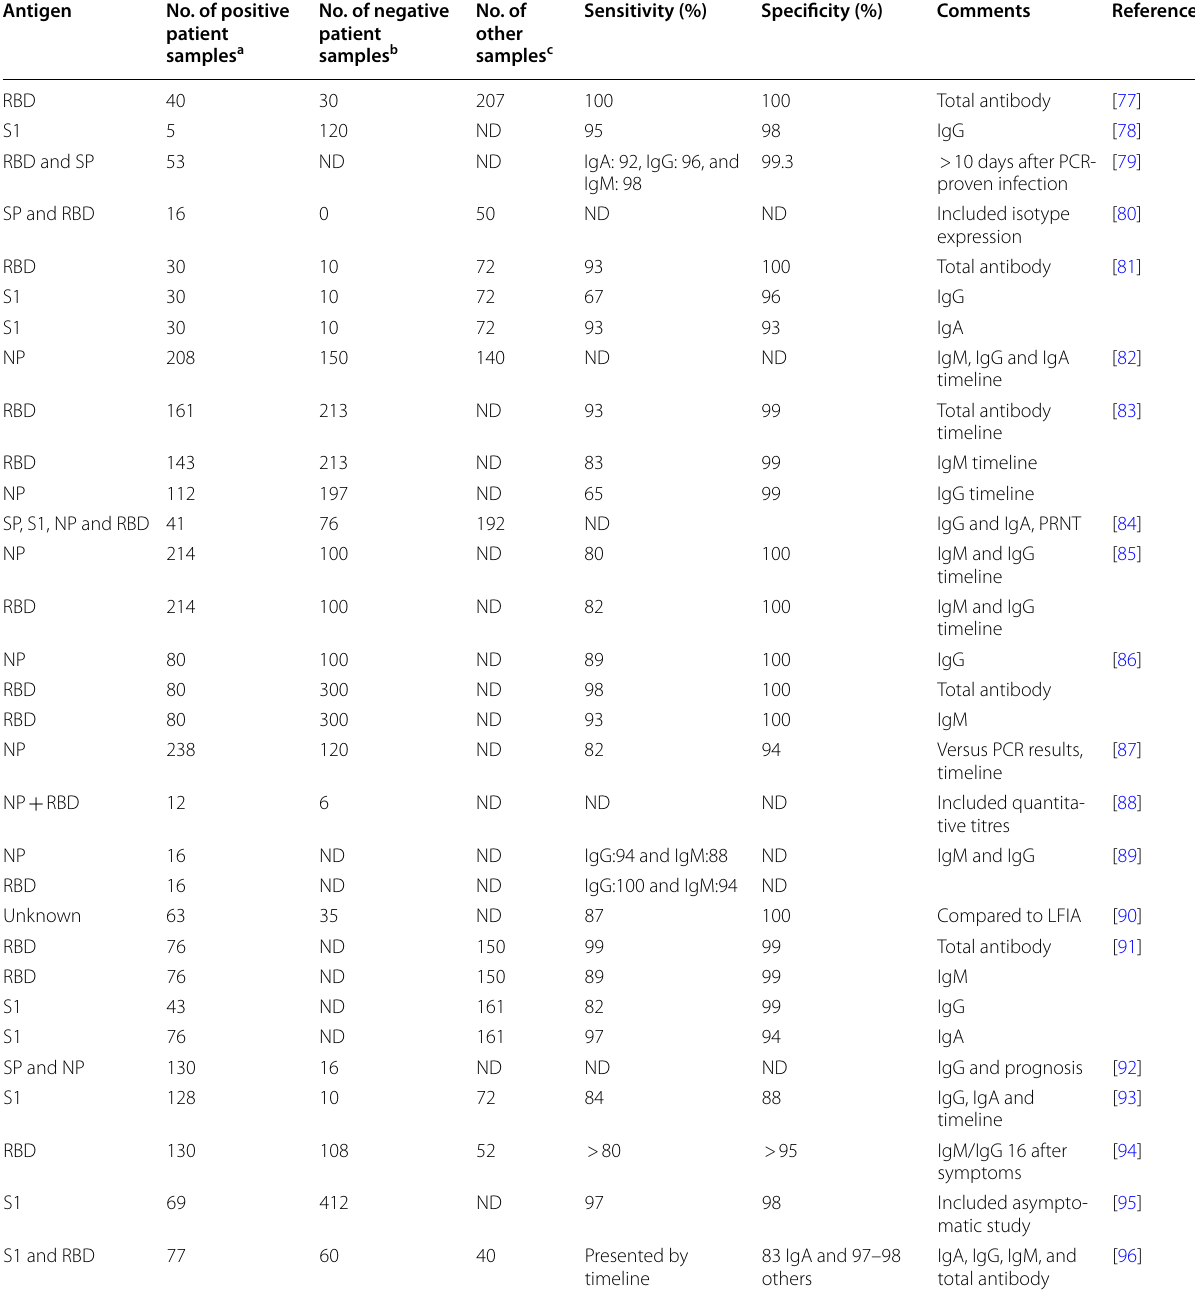
Table 2 List of ELISA applications in the detection of SARS-CoV-2 (adapted and modified from Espejo et al . [76])